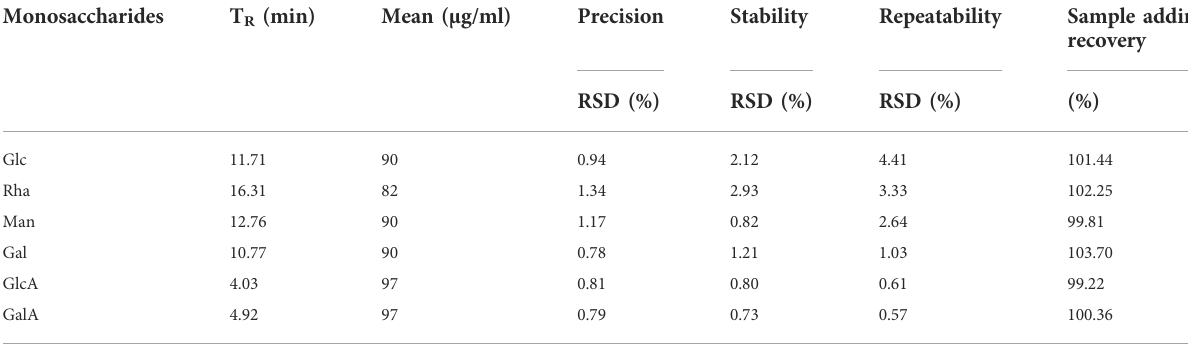
TABLE 2 Precisions, Stability test, Repeatability test and Sample adding recovery test of N2-monosaccharides.